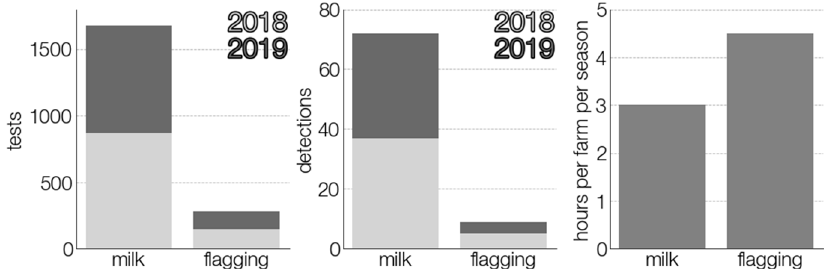
Figure 6. Comparison of two TBEV surveillance strategies. The time spent on sample collection is calculated assuming that it takes two and a half hours for one person to collect ticks and another two hours for tick characterization and pool formation.